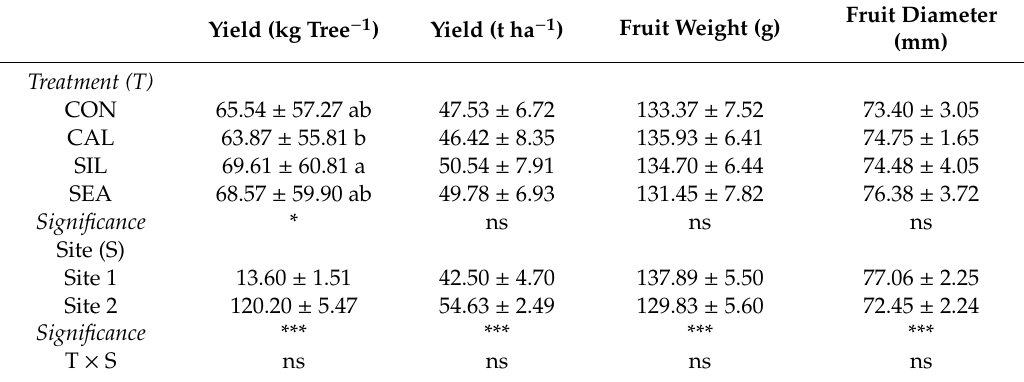
Table 2. Yield parameters at harvest as a ff ected by treatments and sites 1 .